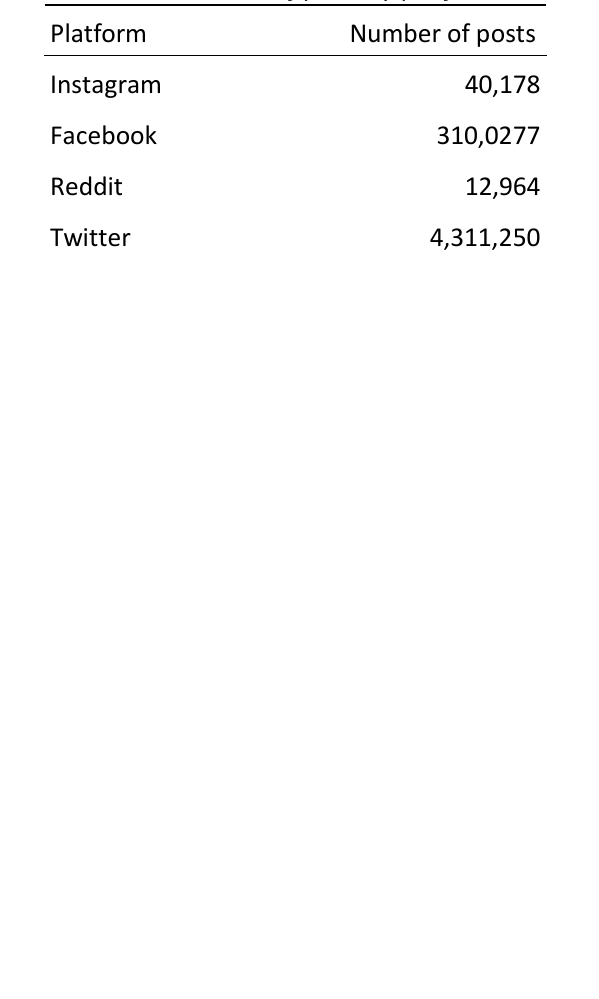
Table 2. Number of posts by